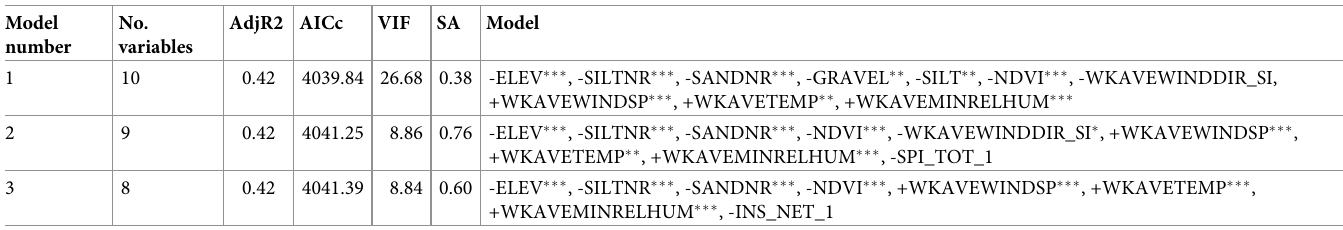
Analysis began with an exploration of non-spatial, global models of responses of phloem feed- ers to both environmental variables and predators (n = 486). Only a subset of the 490,935 regression trials passed cutoffs of model diagnostics. Lowest AICc values were found for a model with 10 of 19 possible variables at 4039.84 (Model 1, Table 8). More parsimonious mod- els were also found to be within 3 AICc points, considered to be comparable, so models up to 4042.84 were also reviewed. Several models with 9 or 8 explanatory variables came into this category. However, in all cases VIF values were > 7.5, indicating multi-collinearity existed in Table 8. Regression model diagnostic values for selected models of phloem feeder abundance. Model